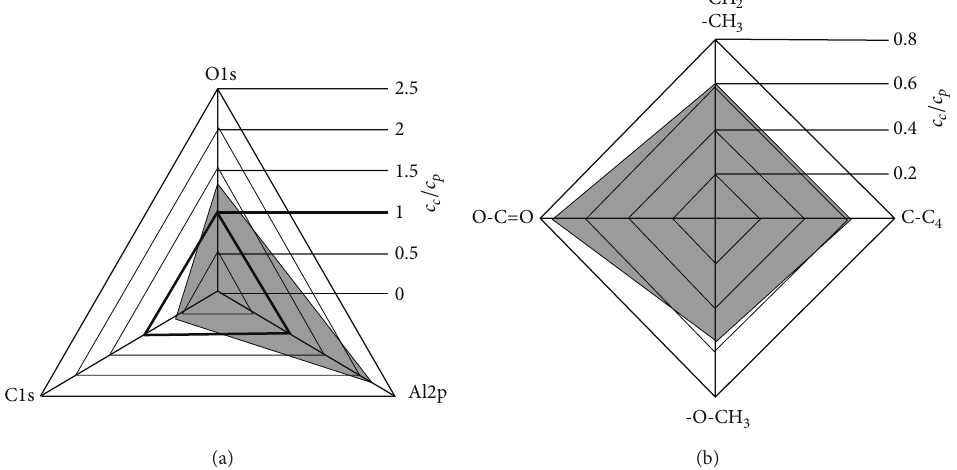
Figure 5: Radar chart of the ratios of particular concentrations obtained from each considered peak after and before the plasma coating process 𝑐 𝑐 / 𝑐 𝑝 .